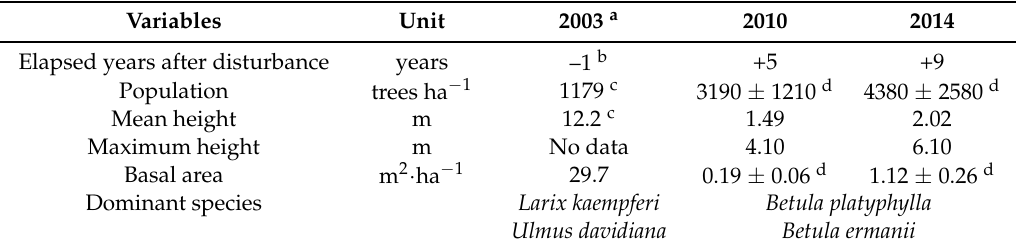
Table 1. Characteristics of overstory trees before (2003) and after (2010 and 2014) the disturbance.